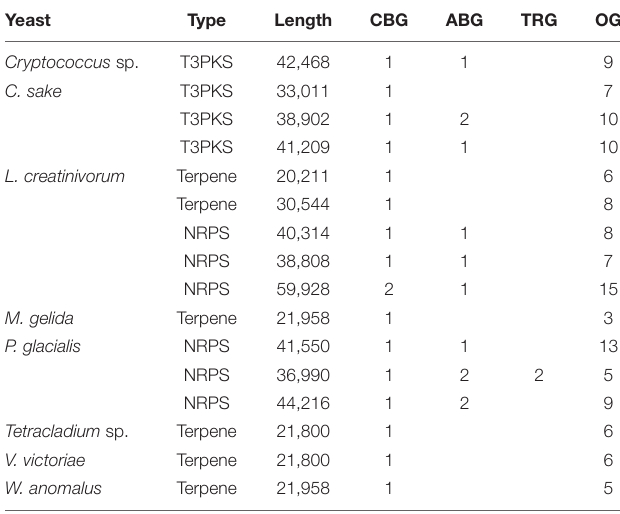
TABLE 2 | Secondary metabolite biosynthesis clusters predicted on draft genomes of Antarctic